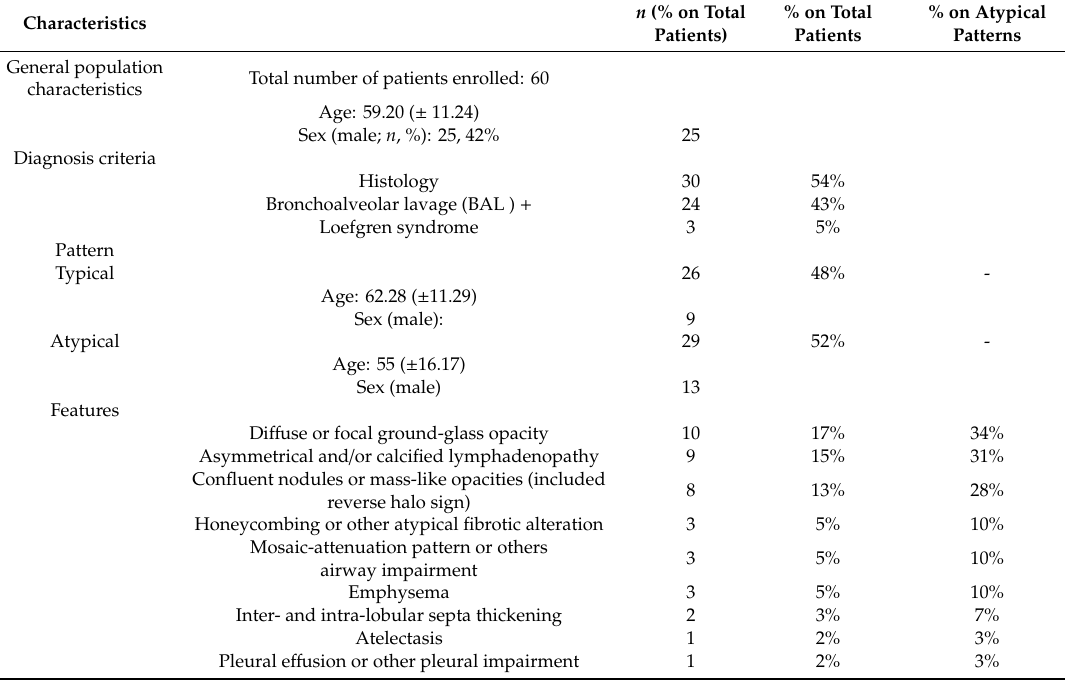
Table 3. Summary of imaging